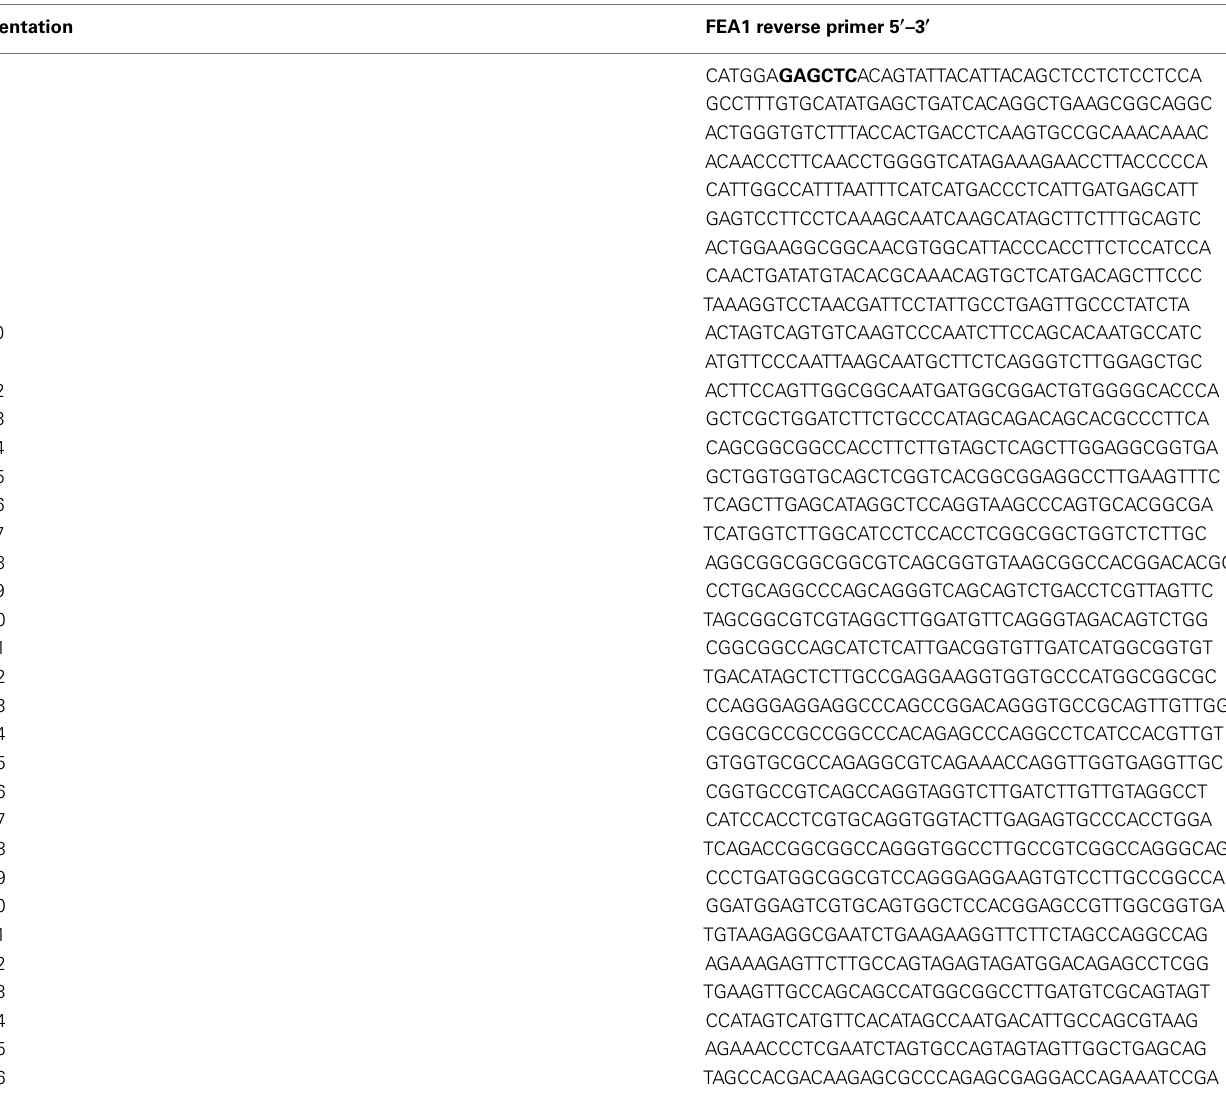
TableA2 | Reverse primers for codon-optimization of Chlamydomonas FEA1 gene for expression in cassava.